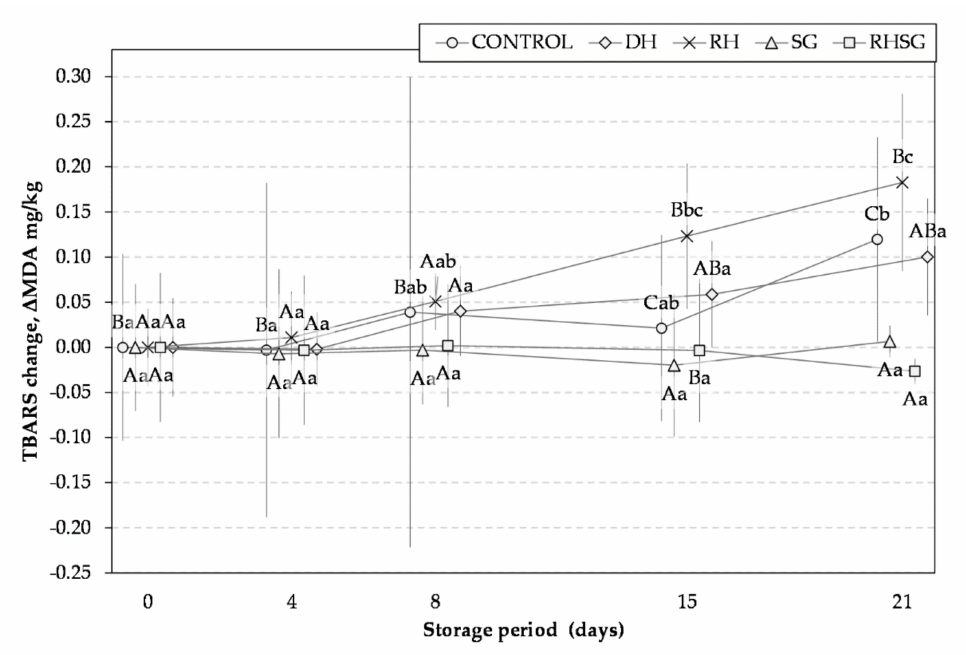
Figure 2. Changes in the TBARS values of grilled pork burger patties stored in the modified atmosphere during the storage period ( ∆ MDA mg/kg). Different capital letters express a significant difference between the variants within the same storage day by the Tukey’s test ( p < 0.05). Different lower-case letters express a significant difference between the storage days within the same variant by the Tukey’s test ( p <